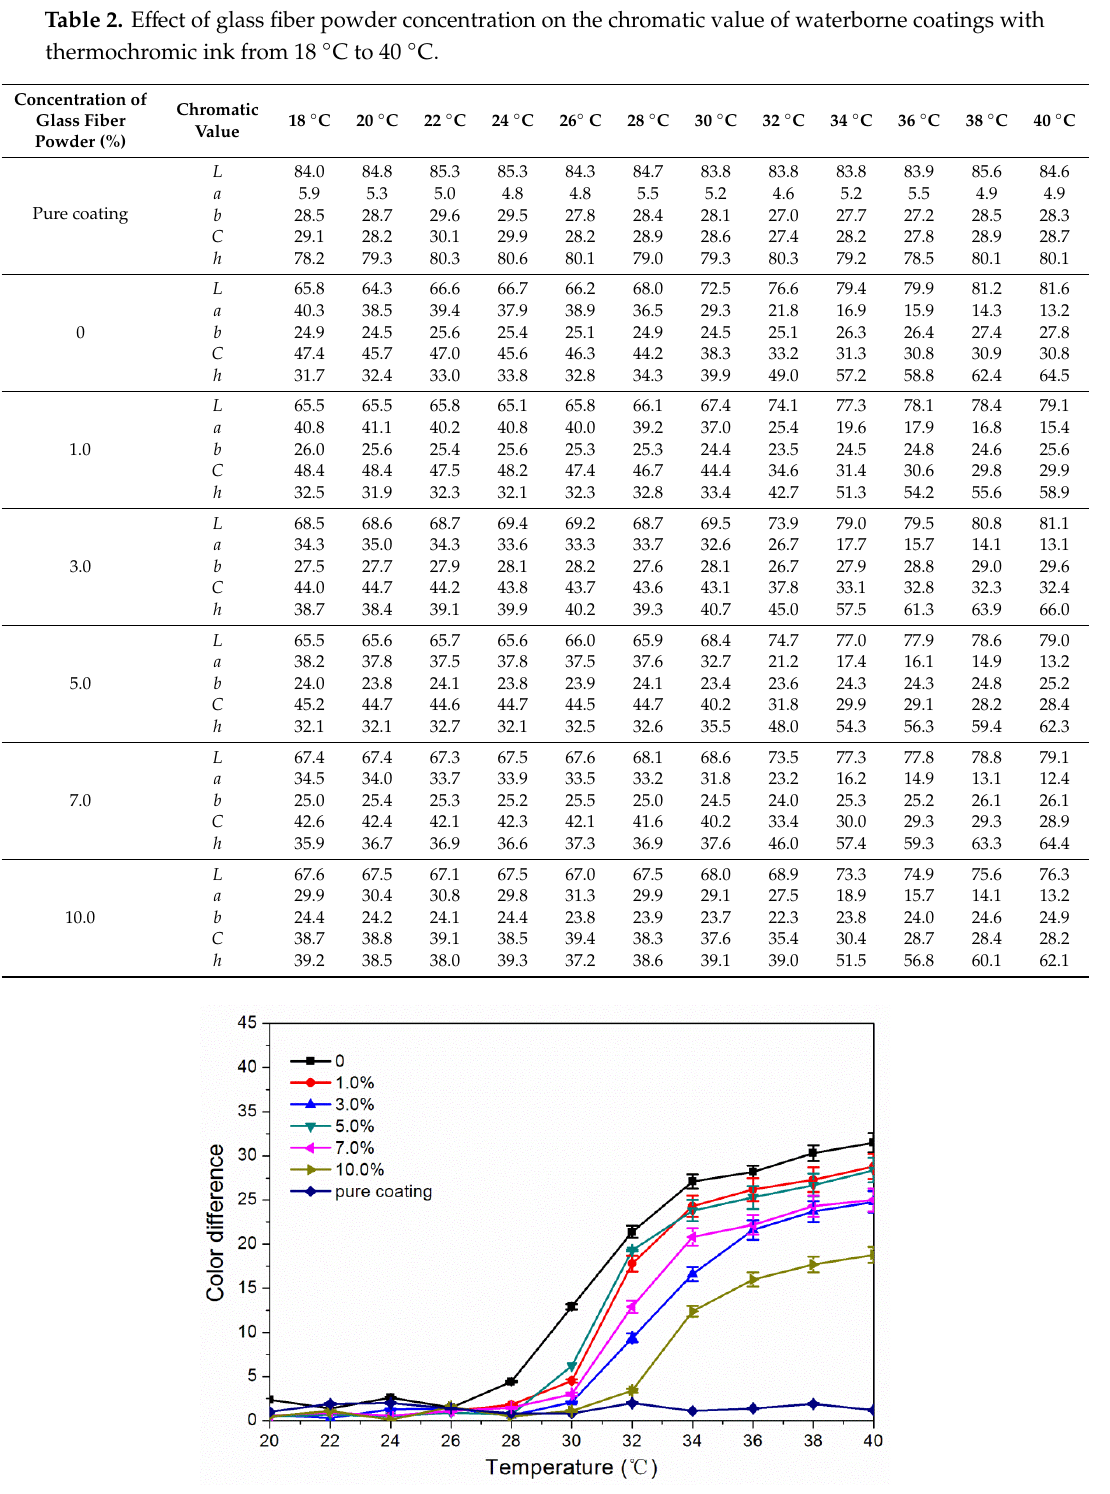
Figure 4. E ff ect of glass fiber powder concentration on the color di ff erence of waterborne coatings with thermochromic ink from 18 to 40 ◦ Figure 4. Effect of glass fiber powder concentration on the color difference of waterborne coatings with thermochromic ink from 18 to 40  C.